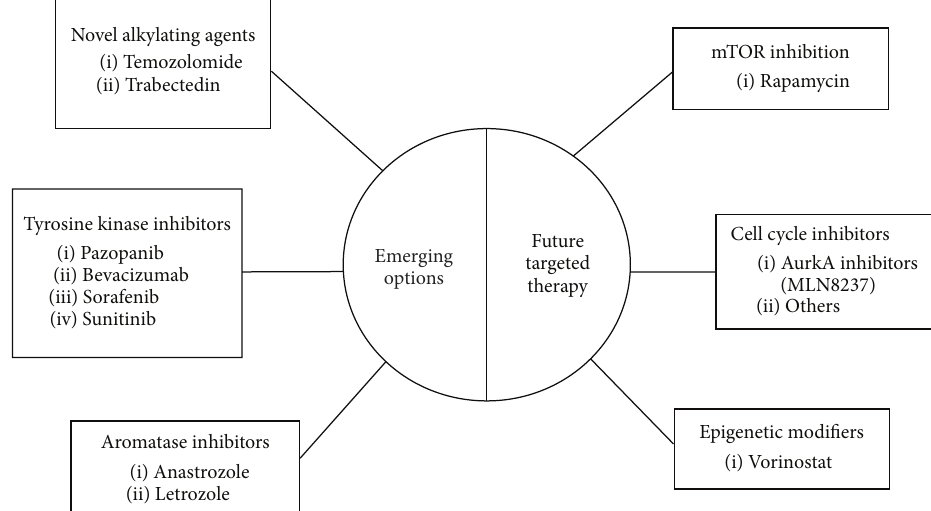
Figure 1: Graphic summary of emerging and potential future targeted therapy for